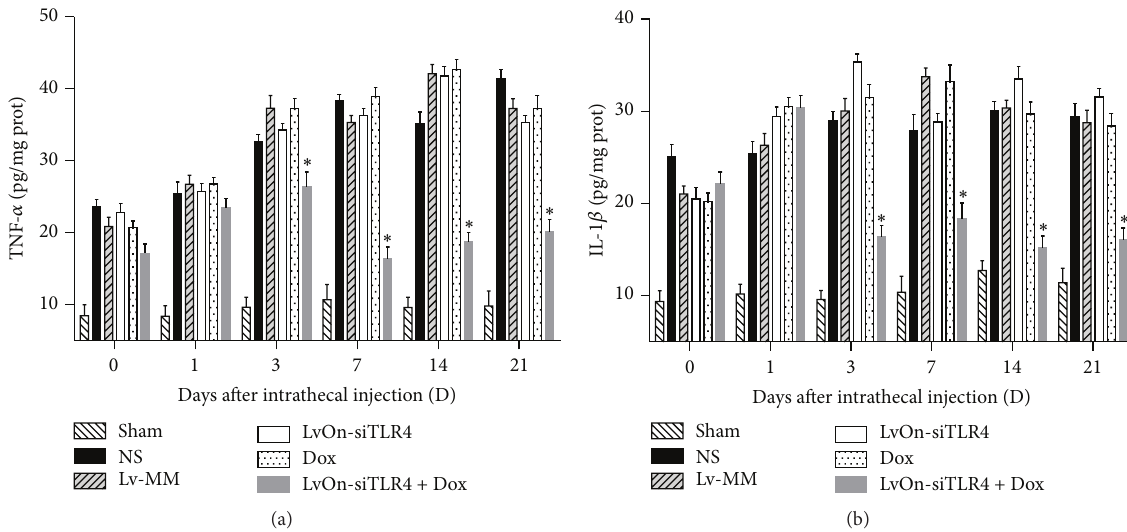
Figure 4: Effects of LvOn-siTLR4 with Dox on proinflammatory cytokine in spinal cord. The dorsal spinal cord tissue samples were prepared on the 1st, 3rd, 7th, 14th, and 21st days after intrathecal injection of the virus for the detection of TNF- 𝛼 and IL-1 𝛽 expression. A significant increase of TNF- 𝛼 (a) and IL-1 𝛽 (b) in the spinal cord was shown in the five groups receiving Walker 256 cells injection. On the 3rd, 7th, 14th, and 21st days after delivery of Lv-siTLR4 with oral administration of doxycycline, the TNF- 𝛼 (a) and IL-1 𝛽 (b) expression decreased markedly in the Lv-siTLR4 with Dox group compared to the other four groups ( ∗ 𝑃 < 0.01 versus Lv-siTLR4 group, Lv-MM group, NS group, and Dox group, two-way ANOVA analysis followed by Tukey’s multiple comparisons, 𝑁 = 6 ). No differences were observed on the 1st day after